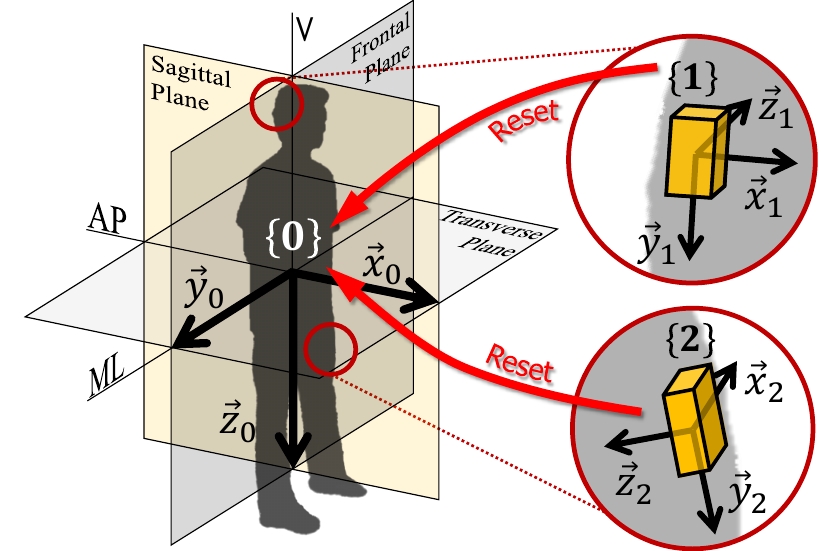
Figure 1. Anatomical